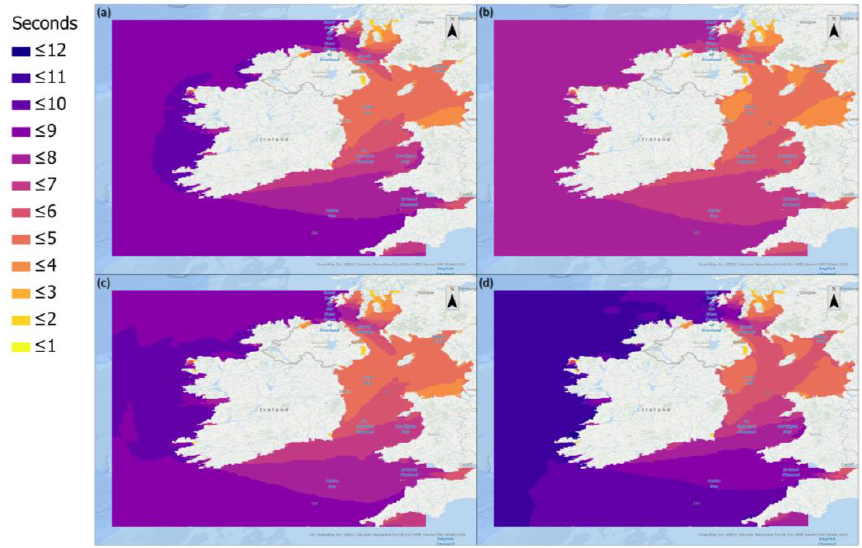
Figure A2. The seasonal mean wave period (T) in seconds for ( a ) spring, ( b ) summer, ( c ) autumn and ( d ) winter.